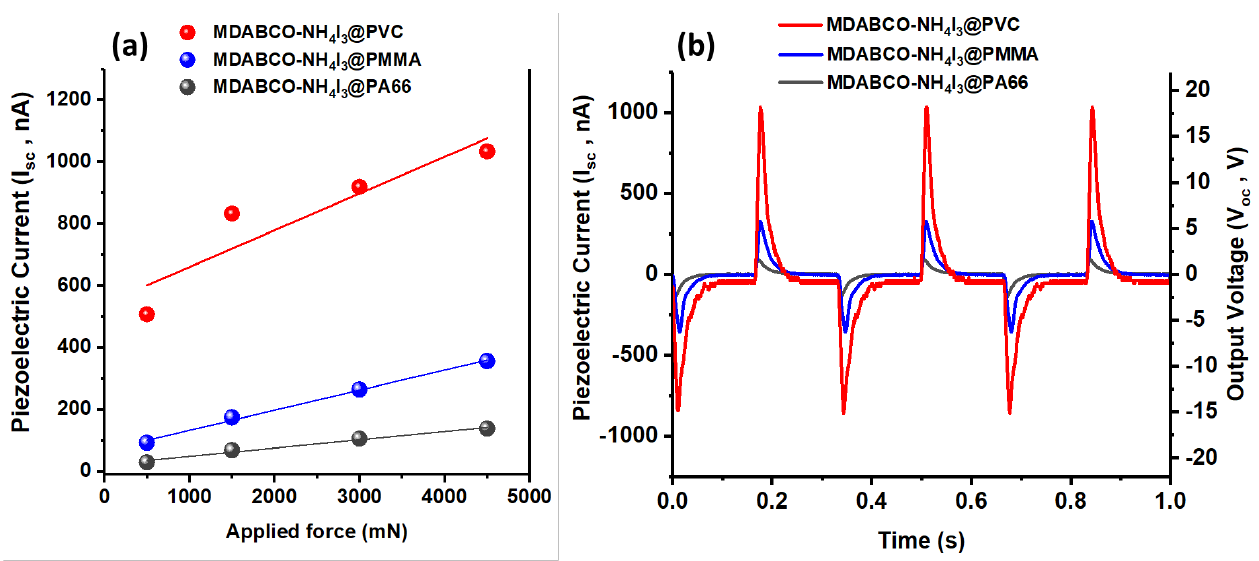
Figure 12. ( a ) Piezoelectric current as a function of the applied forces and ( b ) Output voltage and current as a function of time from MDABCO-NH 4 I 3 incorporated into different electrospun polymer nanofibers.